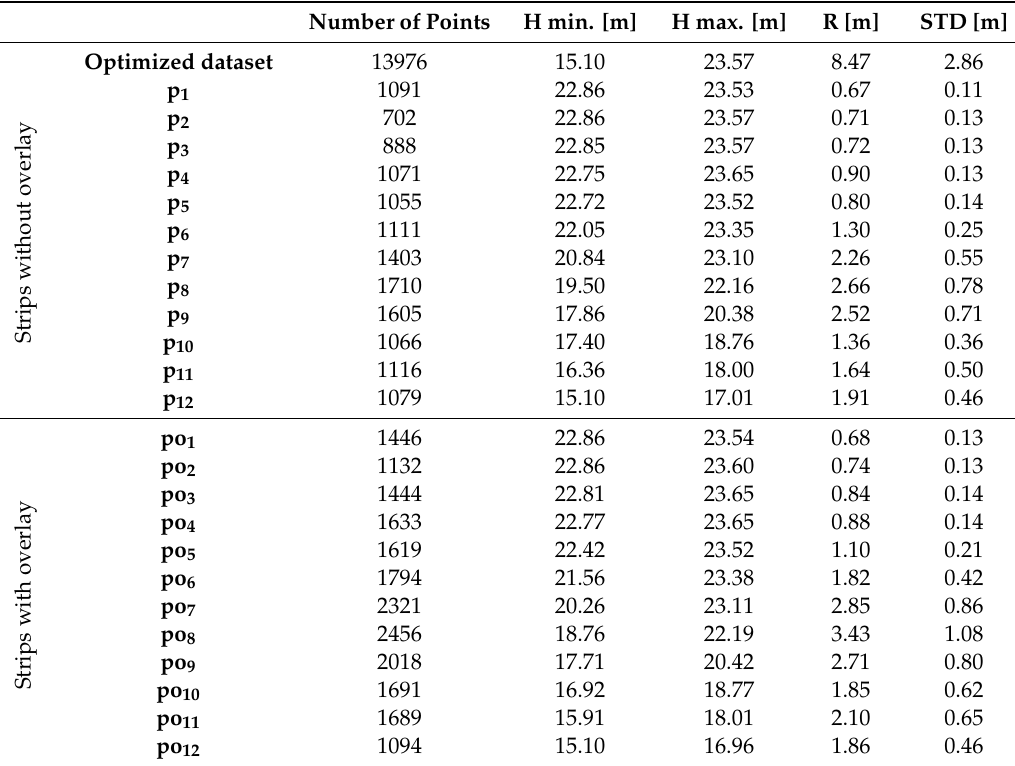
Table 2. Statistical characteristics for datasets in methodology v2. (Where: H—height, R—range, STD—standard